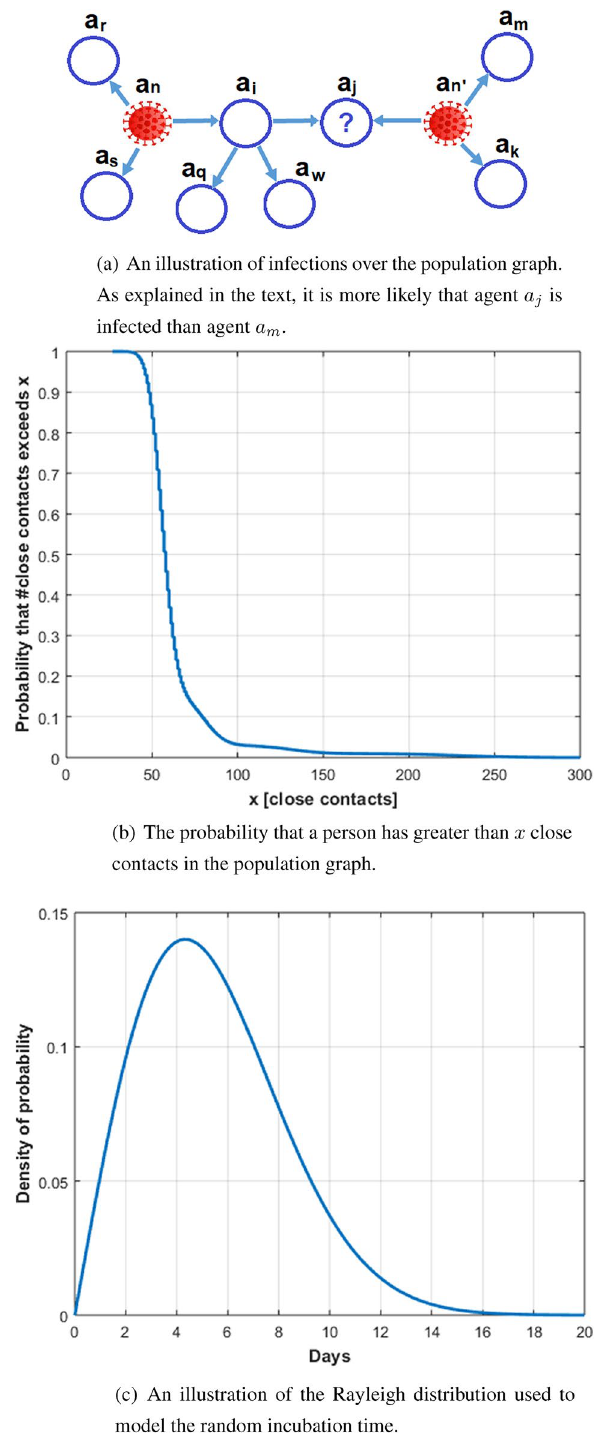
Figure 5. Illustrations for model settings as described in the “Methods”